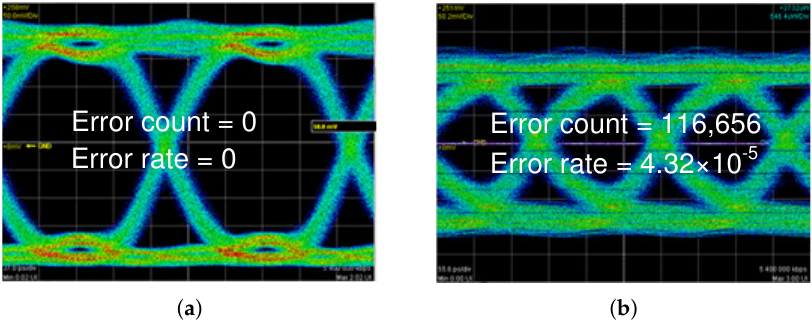
Figure 2. Error pattern observed by the previous 60 GHz RF circuit. ( a ) Error count = 0, Error rate = 0; ( b ) Error count = 116,656, Error rate = 4.32 × 10 − 5